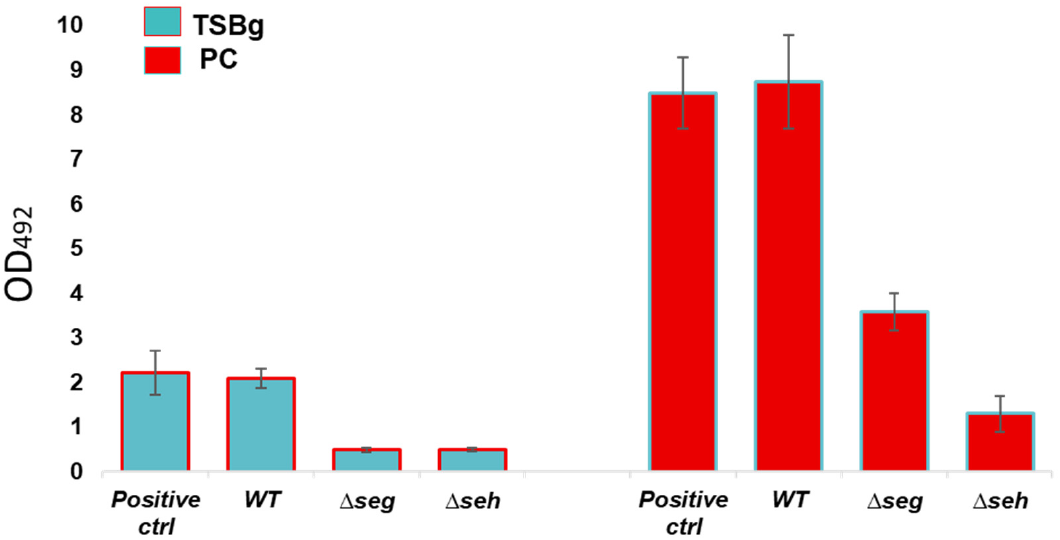
Figure 5. Biofilm formation assessment of S. aureus CBS2016-05 wild type versus derivative entero- toxin mutant strains. The bacterial strains were incubated in trypticase soy broth supplemented with 0.5% glucose (TSBg) at 37 °C in static conditions for 24 h and in platelet concentrates (PCs) incubated at 20 ± 2 °C under agitation for 5 days. N = 3; error bars are standard deviation based on three replicates. S. aureus ATCC 25923 (positive control strain).